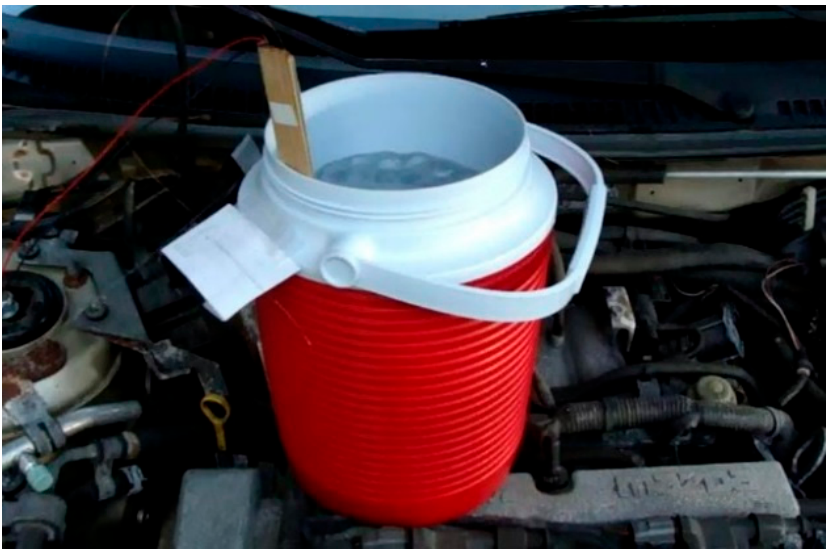
Figure 5. The water level measured by the fiber sensor in a container placed on a running car engine.